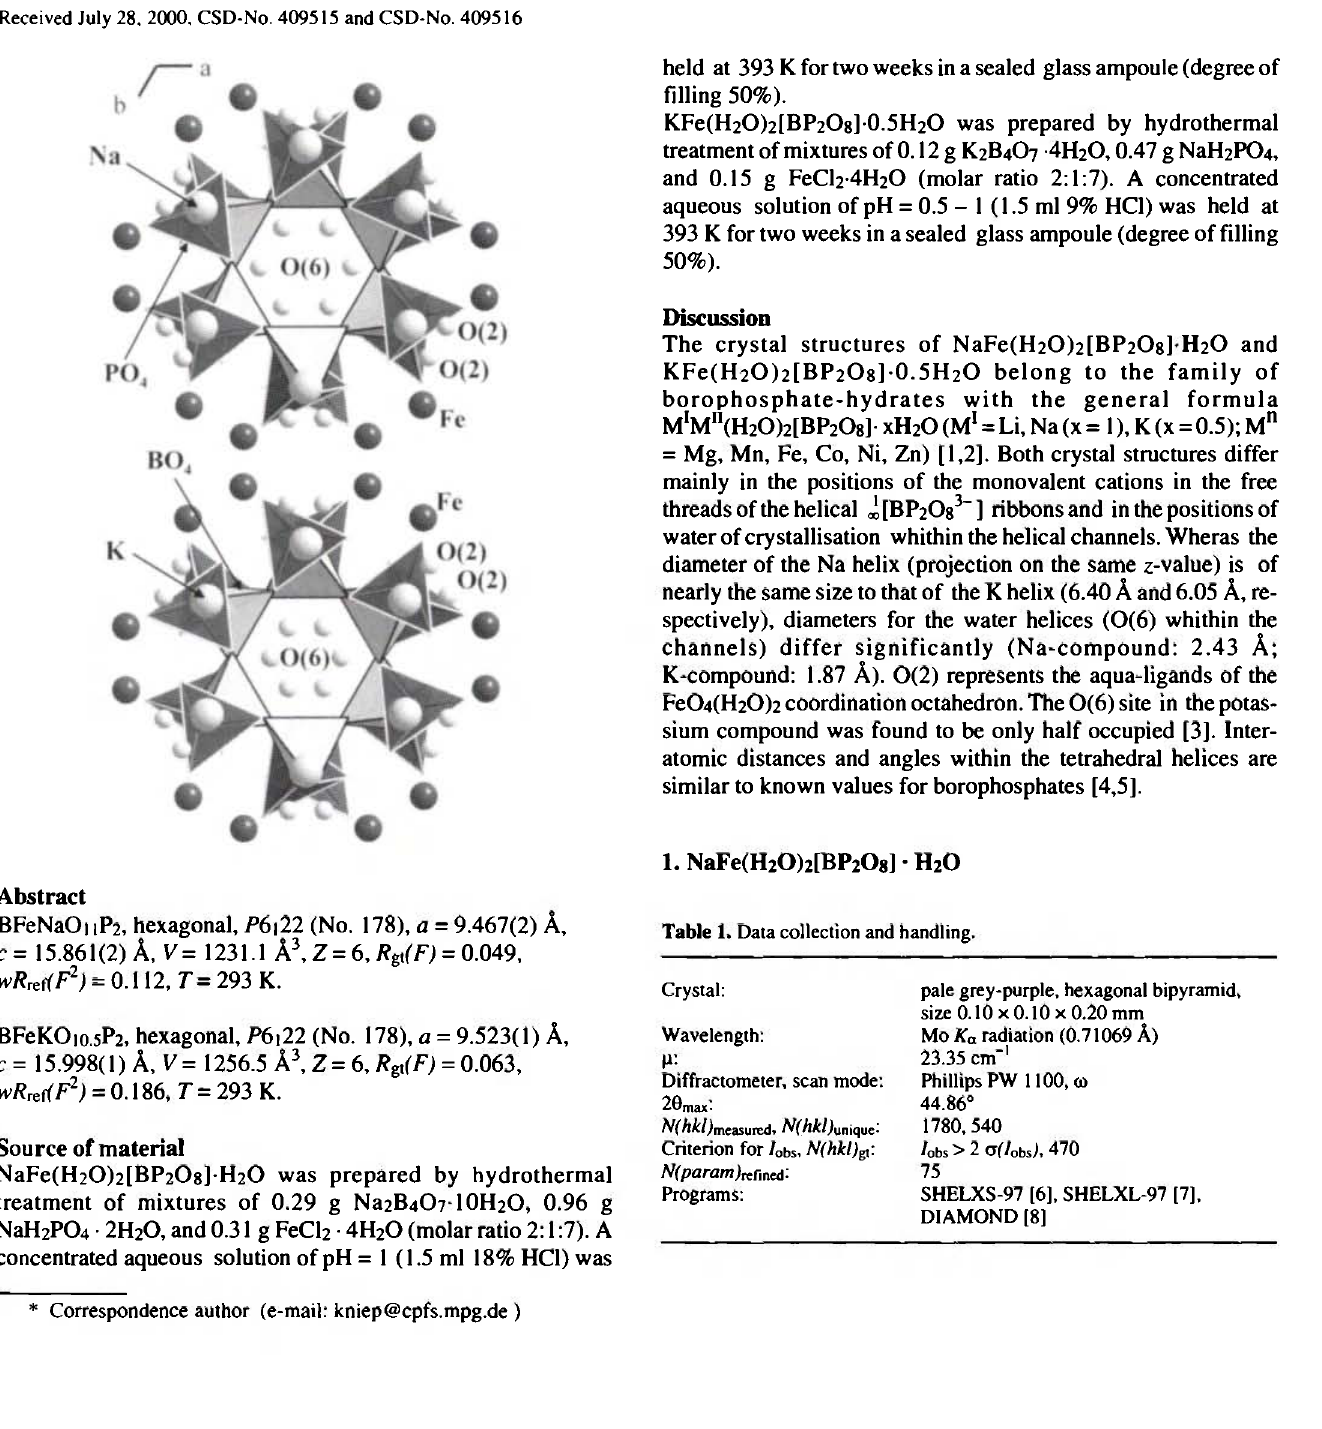
Table 1. Data collection and handling.